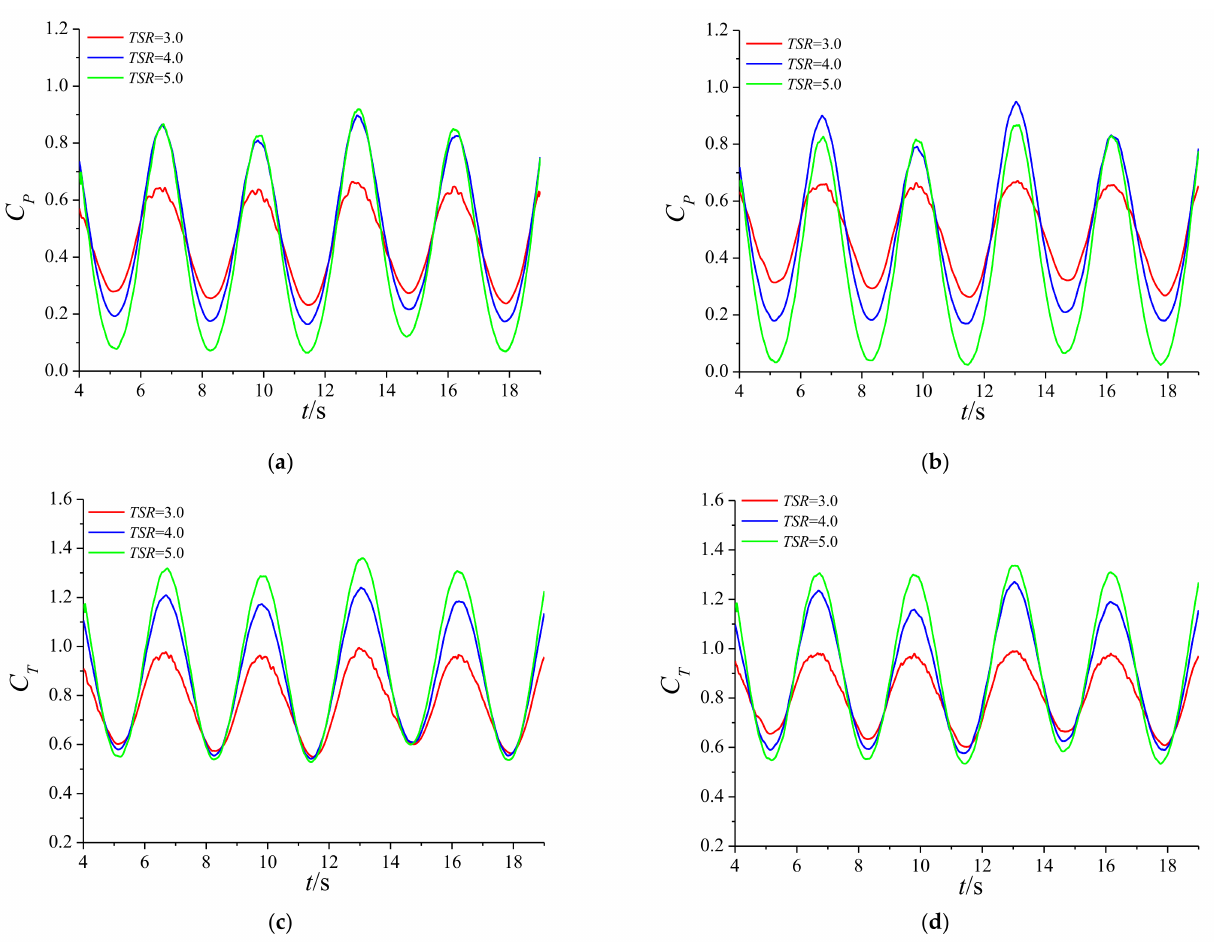
Figure 10. Time histories of C P and C T for the two configurations at different values of TSR : ( a ) C P for DT; ( b ) C P for RDT; ( c ) C T for DT; ( d ) C T for